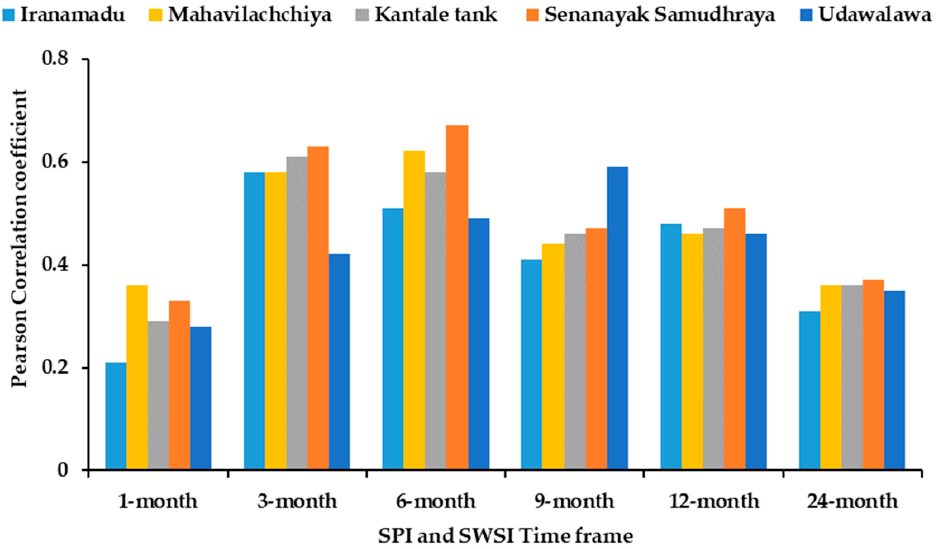
Figure 11. Pearson correlation coefficients between SPI and SWSI in 1, 3, 6, 9, 12, and 24 timeframes.